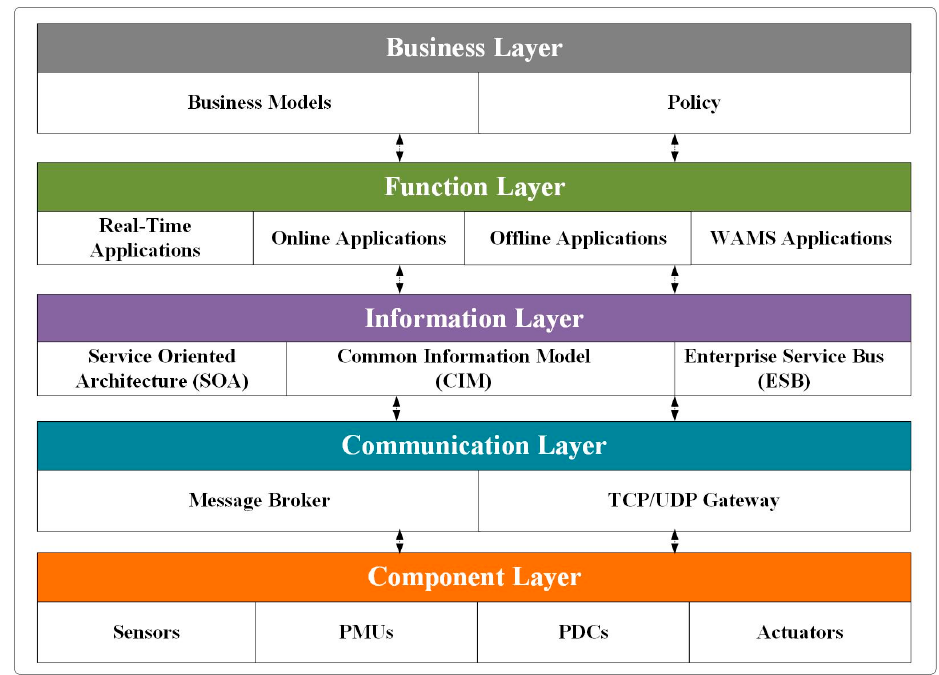
Figure 2. Wide-area measurement system (WAMS) architecture.